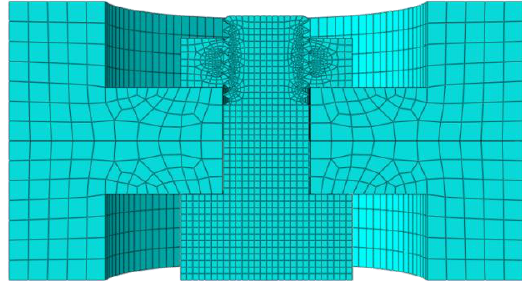
Figure 7. Finite element model of threaded connections and mesh.